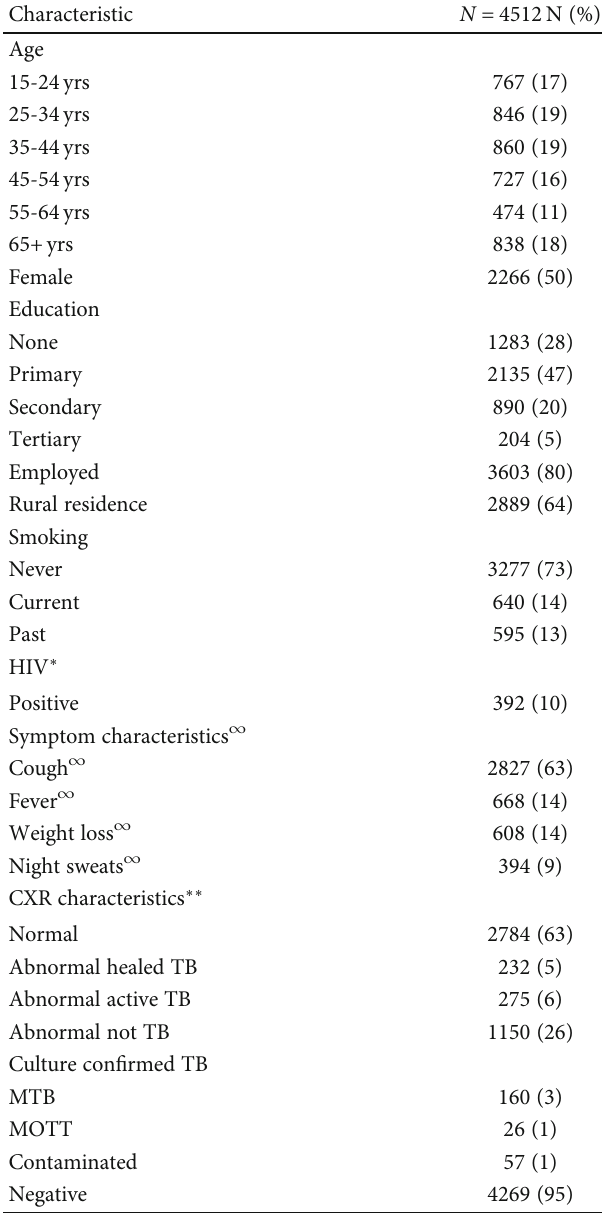
Table 1: Demographic, clinical, and radiographic characteristics of the study